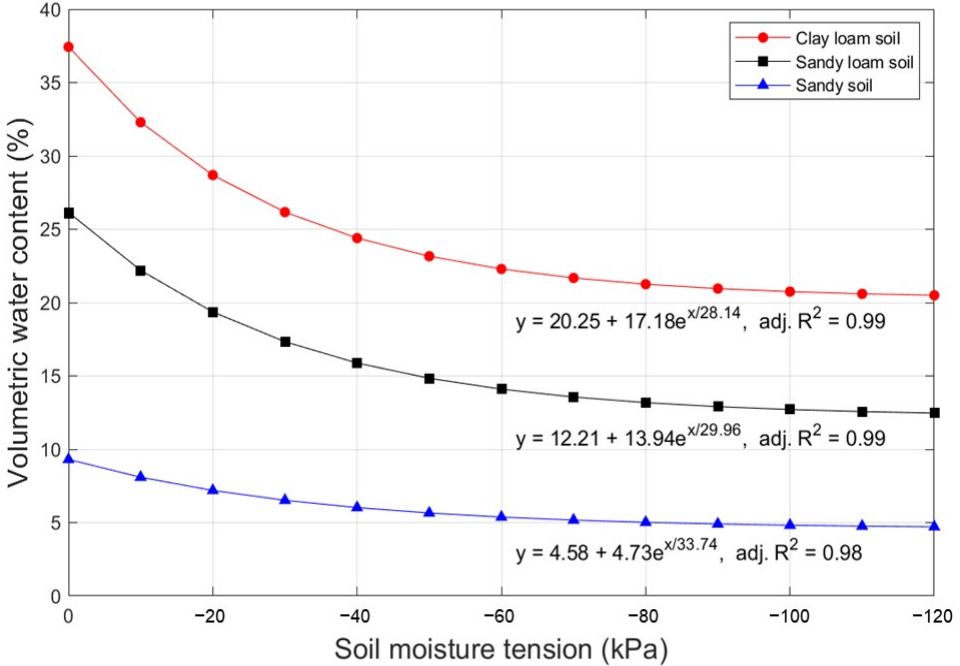
Figure 6. The formula to convert soil moisture tension to volumetric water content.